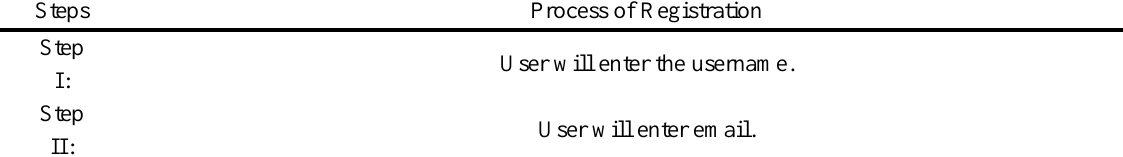
Table 1. Process of registration.